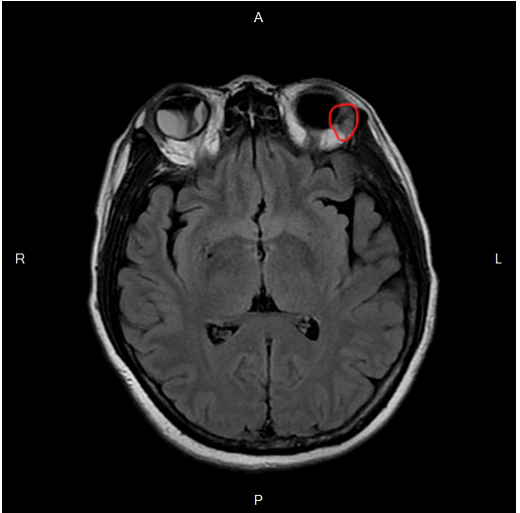
Figure 2. T2-weighted magnetic resonance image demonstrates retinal detachment in the right eye and a lesion on the temporal side with orbital rim enhancement in the left eye (red circle).